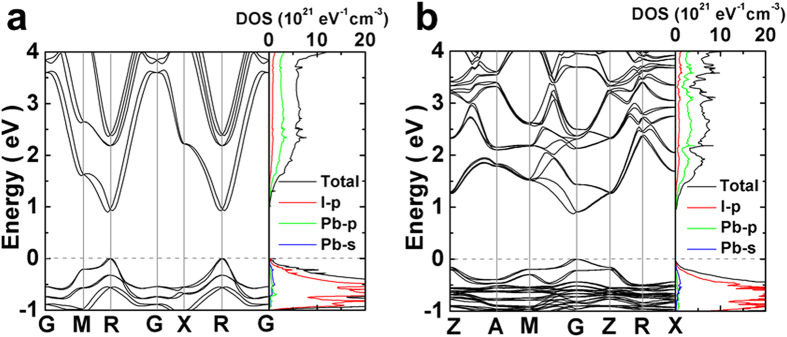
Band structure and partial density of states.(a) Cubic CH3NH3PbI3. (b) Tetragonal CH3NH3PbI3.